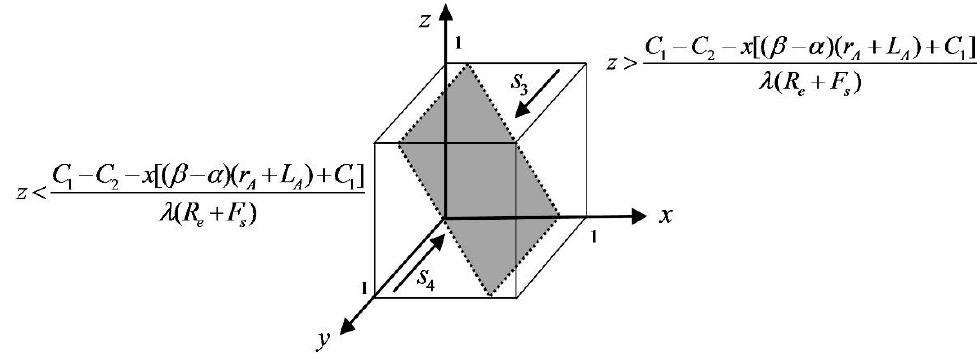
Figure 3. Phase diagram of dynamic trends in the platform service providers.